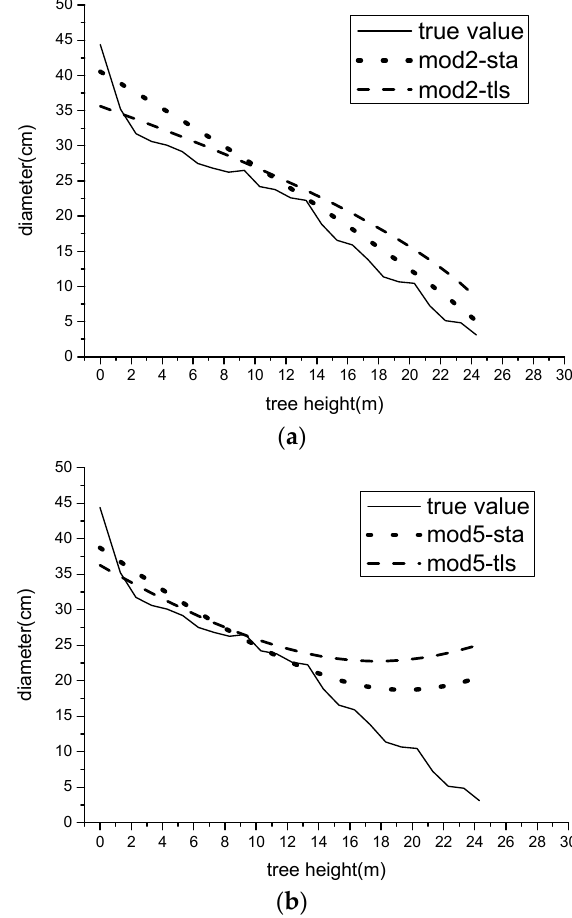
Figure 2. Predicted stem diameter in relation to tree height, as derived using stem analysis (sta) and laser scanning data (tls), from Model 2 ( a ) and Model 5 ( b ). Also shown are the corresponding measured (true) values. Table 7. Comparison of Equation (2) predictions when calibrated with stem analysis versus terrestrial laser scanning (TLS) data.